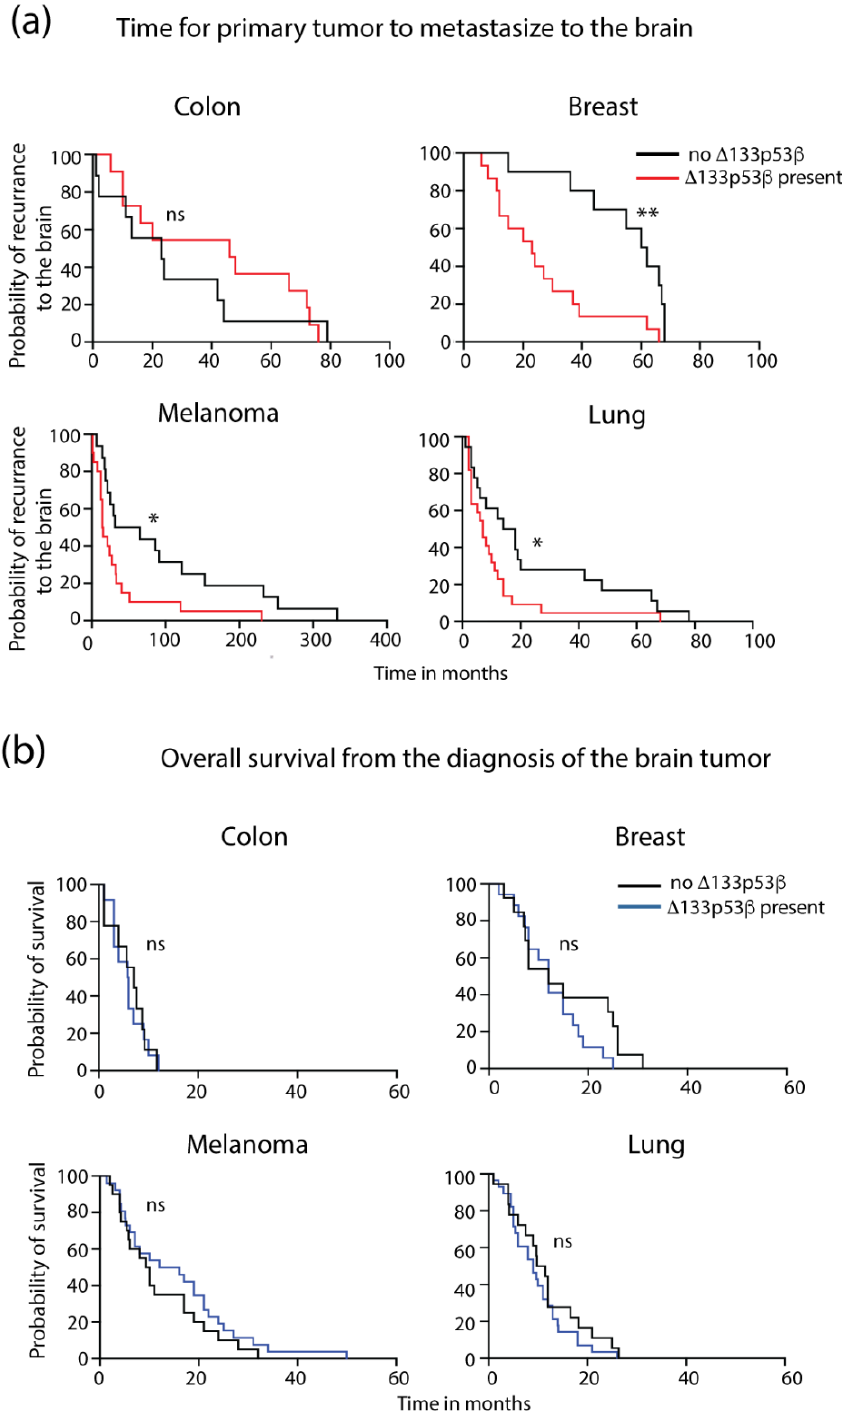
Figure 2. Patient outcome based on tumor ∆ 133p53 β expression. ( a ) Time for the primary tumor to progress to the brain. ( b ) Overall survival time once the tumor was diagnosed in the brain. ∆ 133p53 β was measured using RNAscope in breast, melanoma, lung and colorectal brain metastases and the patient outcomes were compared between those with ∆ 133p5 3 β -expressing (high, medium, or low) tumors and those with no ∆ 133p53 β expression. * p < 0.05; ** p < 0.01; ns, not significant. We next investigated whether there was an association between Δ133p5 3 β expression and mutant p53, as mutant p53 promotes metastasis [10]. Immunohistochemistry was used as a surrogate for identifying tumors with mutant p53 based on mutations in p53